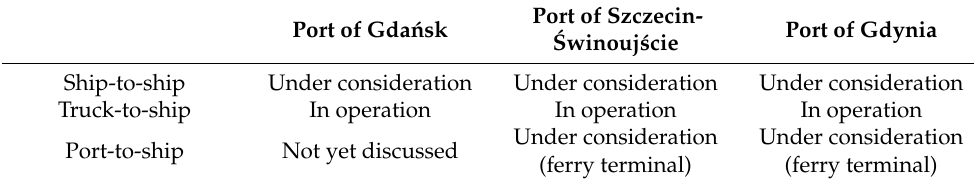
Table 10. LNG bunkering methods available in the surveyed Polish